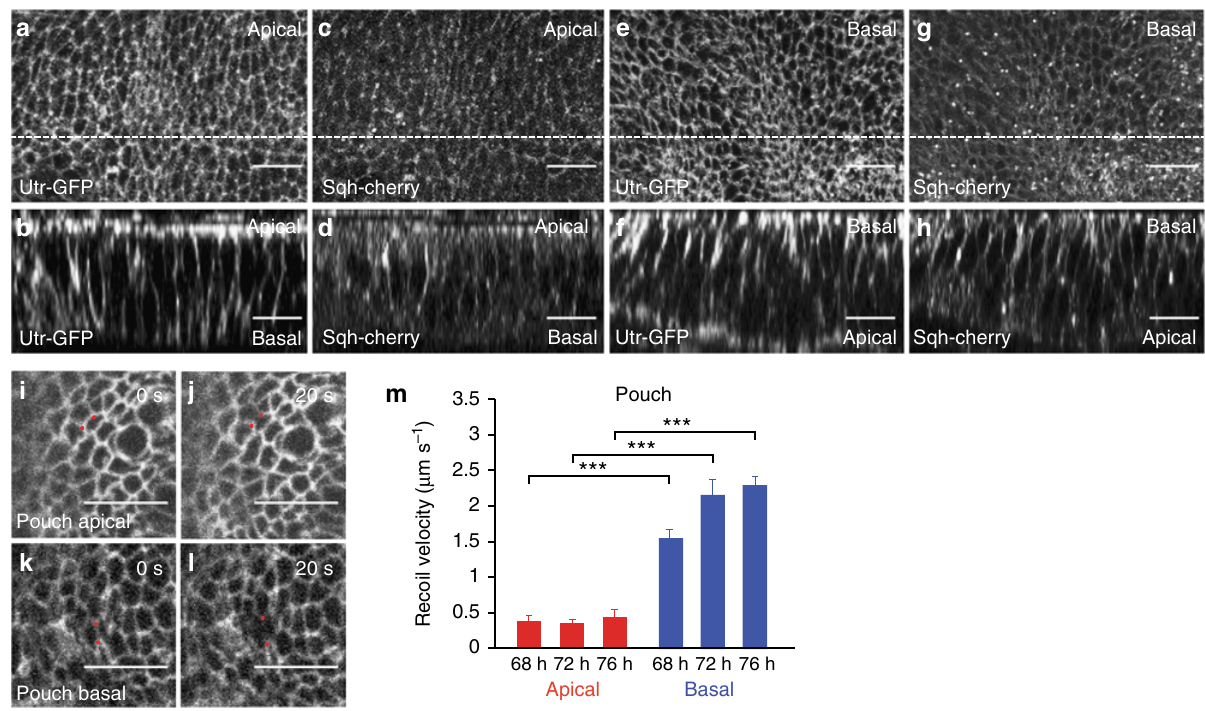
Fig. 3 Basal tension is higher than apical tension outside folds. a – h Apical ( a , c ) and basal ( e , g ) views and cross-sectional images ( b , d , f , h ) of wing imaginal discs of 72 h AEL larvae co-expressing Utr-GFP and Sqh-cherry to visualize F-actin and Myosin regulatory light chain, respectively. The apical and basal sides of the columnar cells are indicated in the cross sections. In a – d the apical side of the columnar cells was mounted closer to the coverslip, whereas in e – h the basal side was mounted closer to the coverslip. Scale bars are 10 μ m. i – l Wing imaginal disc pouch cells of 72 h AEL larvae expressing Indy-GFP before and 20 s after ablation of a single cell edge at the apical ( i , j ) or basal ( k , l ) side of the pouch epithelium. Scale bars are 10 μ m. Red dots mark vertices of ablated cell edges. m Average recoil velocity of the two vertices at the end of an ablated cell edge within 0.25 s after ablation in the pouch region for wing imaginal discs of the indicated times AEL. Recoil velocities are shown for ablations of apical and basal cell edges, as indicated. Mean and s.e. m. are shown ( n = 15 cuts) (*** p < 0.001, Student ’ s t